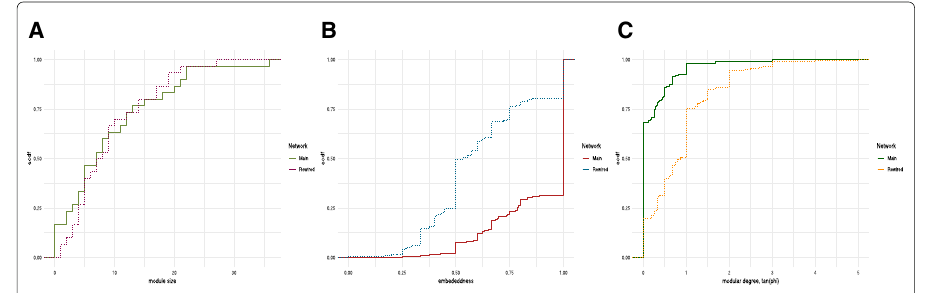
Fig. 4 Empirical cumulative density functions (ecdf) of modular structure descriptors based on topological features, for the Main and Rewired networks. Panel a ecdf of module size. Panel b ecdf of node embeddedness (see Lancichinetti et al. (2010)). Panel c ecdf of the tangent (phi argument) of the modular degree, as defined in Ghalmane et al. (2018)